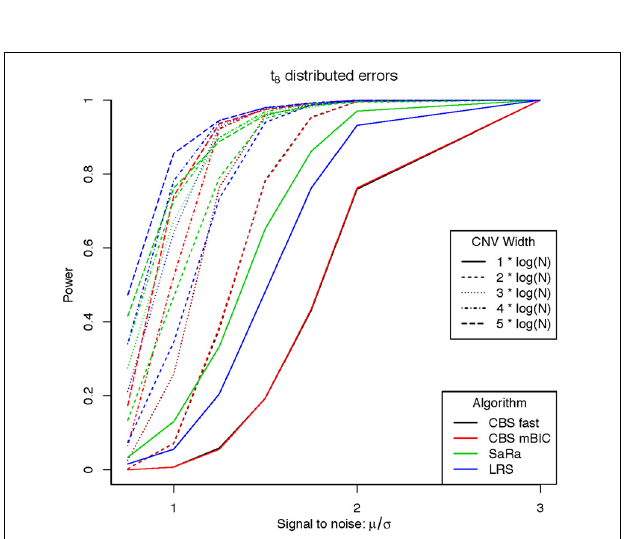
FIGURE 2 | Power for different signal to noise and CNV width under a heavy tailed (t 8 )